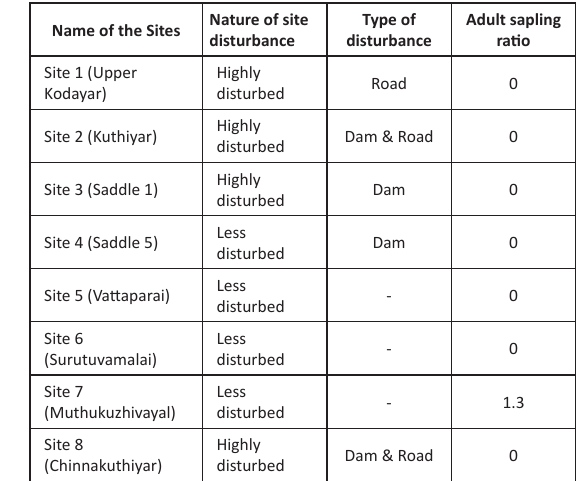
Table 3. Habitat degradation and adult sapling ratio